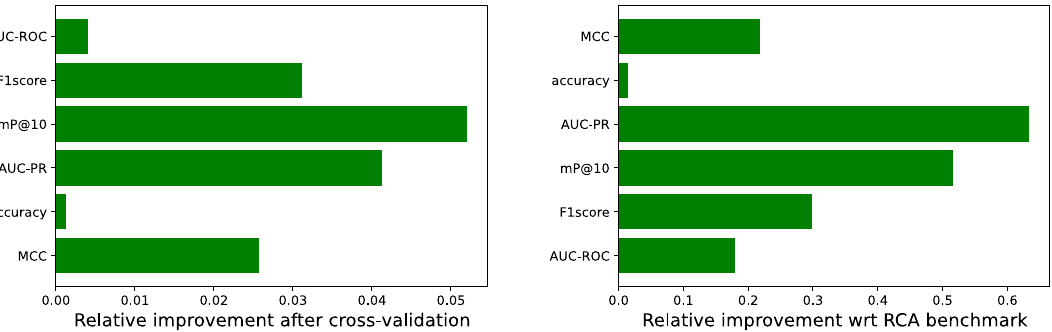
Figure 4. Left: relative improvement of the prediction performance of XGBoost when the training is cross validated. The algorithm now can not recognize the country, and so all the performance indicators improve. Right: relative improvement of the cross validated XGBoost algorithm with respect to the RCA benchmark.